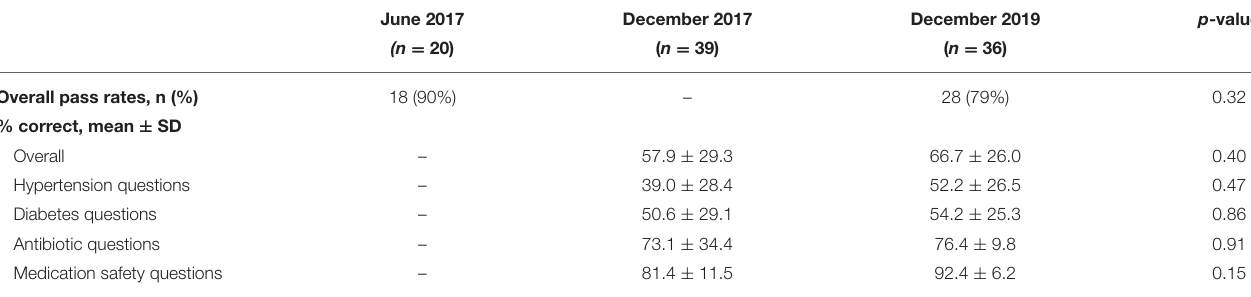
TABLE 3 | Results of knowledge